Question: In one sentence, what is this figure communicating?
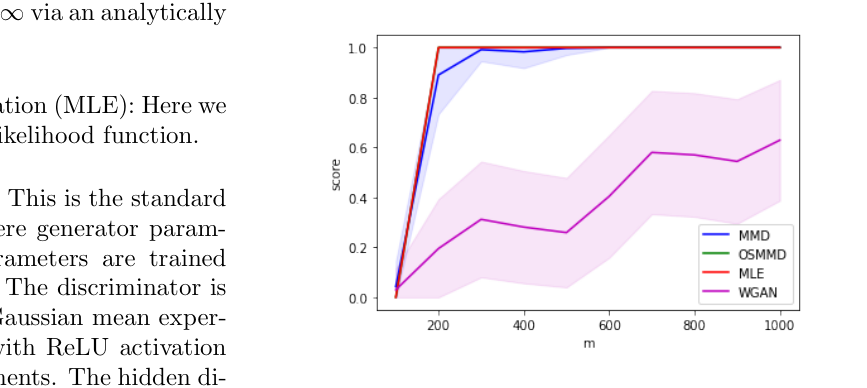
Answer: Success rate in a 2-GMM model with un- known mean as a function of m. OSMMD and MLE coincide.